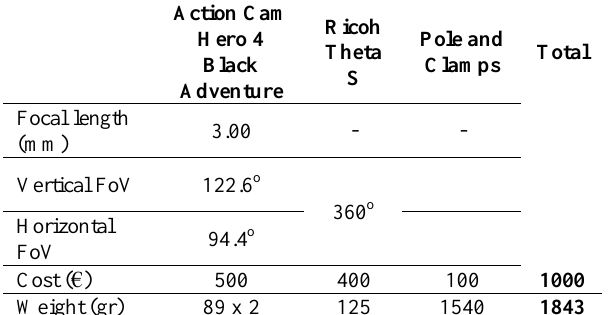
Table 1: Cost and weight of system